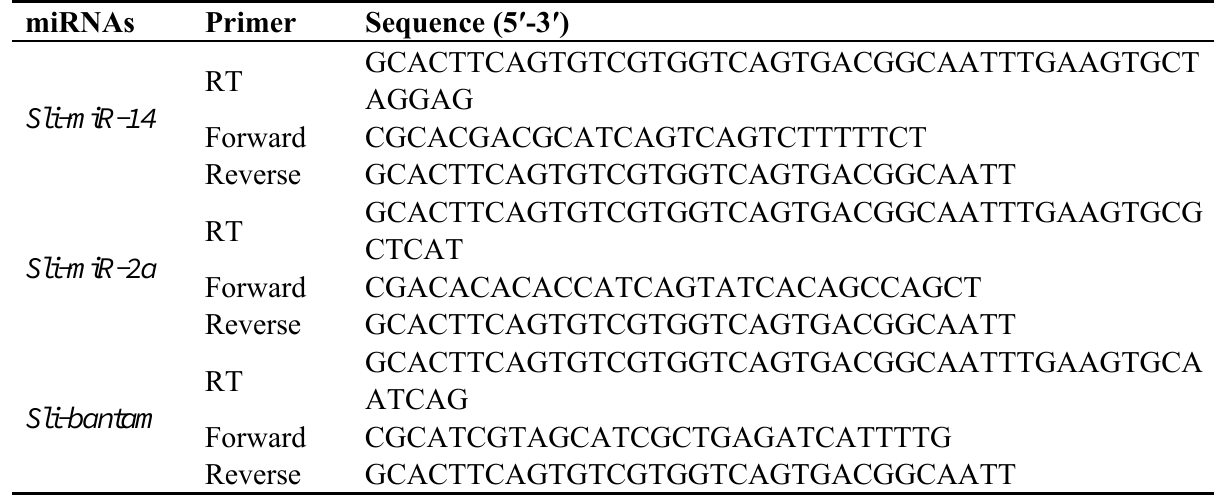
Table 3. Sequences of stem-loop RT primers, forward primers and reverse primers of Group